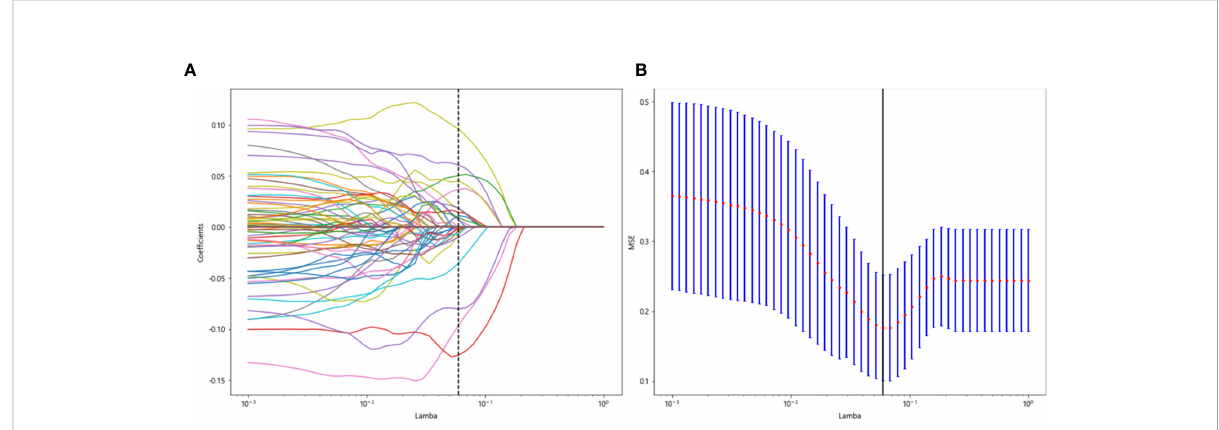
FIGURE 12 Regression feature screening. (A) Feature selection plot for the LASSO regression, which was adjusted by a super parameter (Lamba) to achieve the purpose of screening the optimal features. The vertical dashed line indicates that the corresponding optimal Lamba value when obtaining the minimum deviation value is Lamba = 0.0596. (B) The convergence graph of characteristic coef fi cients for feature selection by cross- validation. Features with non-zero coef fi cients were screened out corresponding to the vertical lines in the plot, with a total of 20 best features